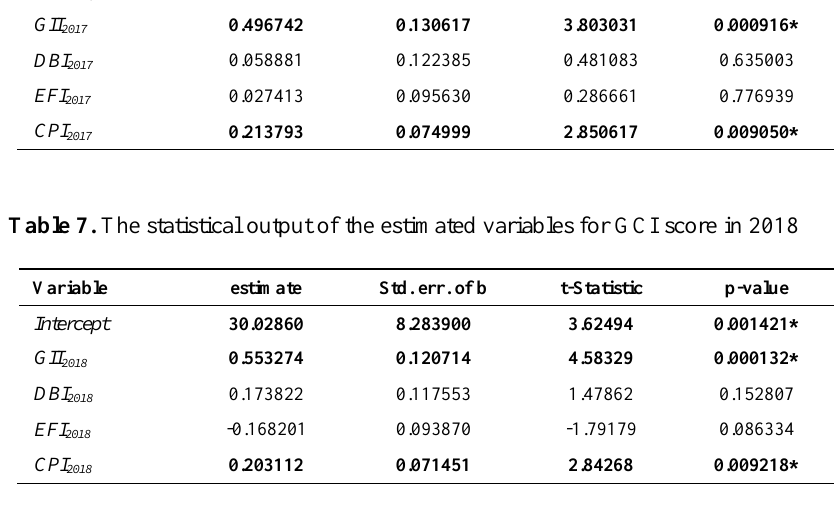
Table 8. The statistical output of the estimated variables for GCI score on